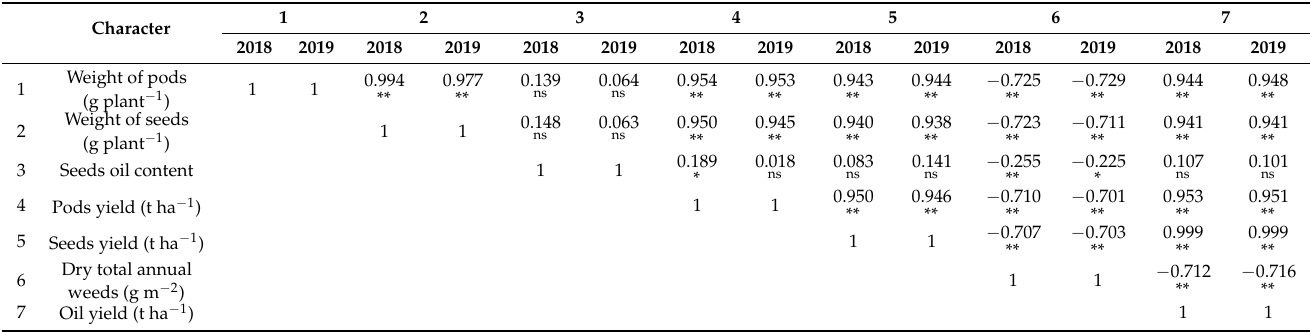
Table 9. A matrix of Pearson’s correlation coefficient between oil yield (t ha − 1 ) and other important traits estimated of peanut during two growing seasons.